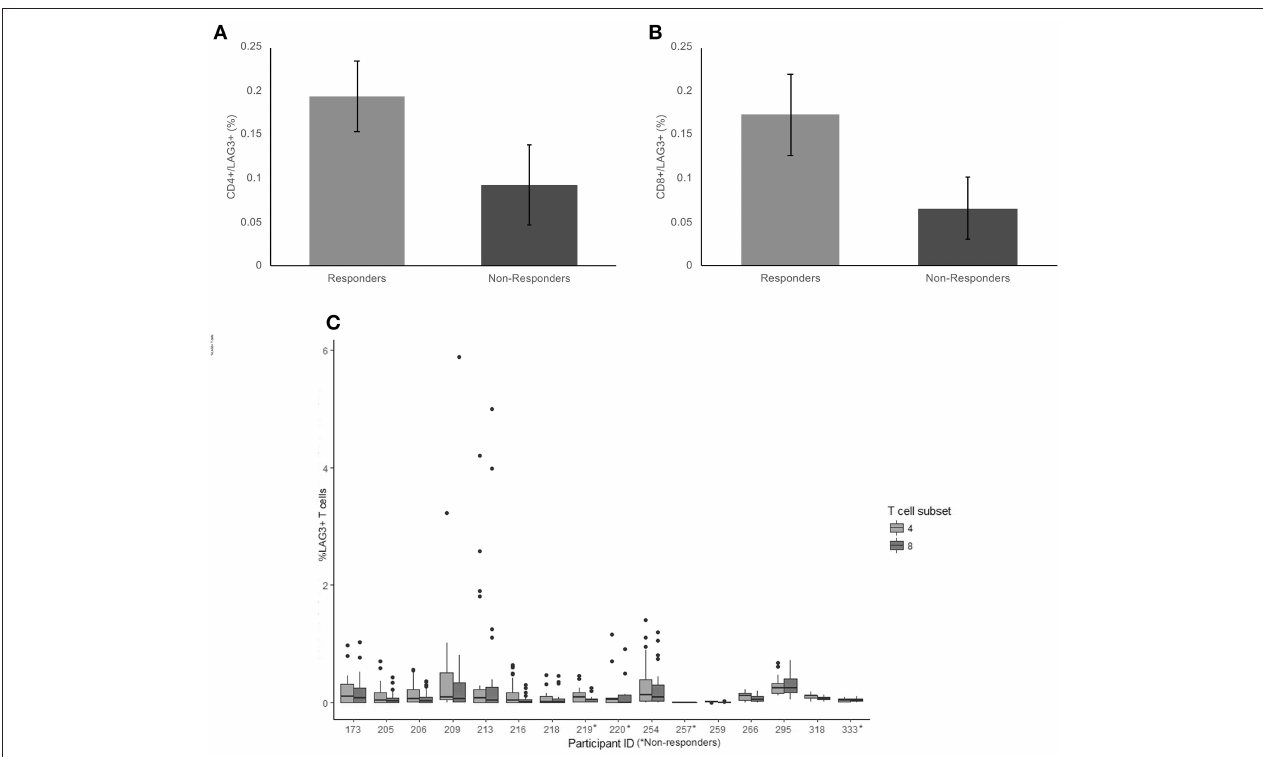
FIGURE 3 | Frequency of LAG3 expression on CD4 + and CD8 + T cells. (A) The mean percentage of CD4 + T cells expressing LAG3 in non-responders responders to pembrolizumab (B) The mean percentage of CD8 + T cells expressing LAG3 in non-responders responders to pembrolizumab (C) Boxplot of mean frequency of LAG3 on CD4 + and CD8 + T cells per patient per